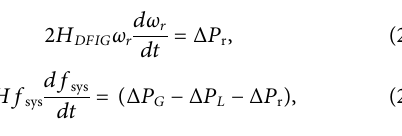
Resultsoftheconventionalschemewithvariousformsof Δ P r